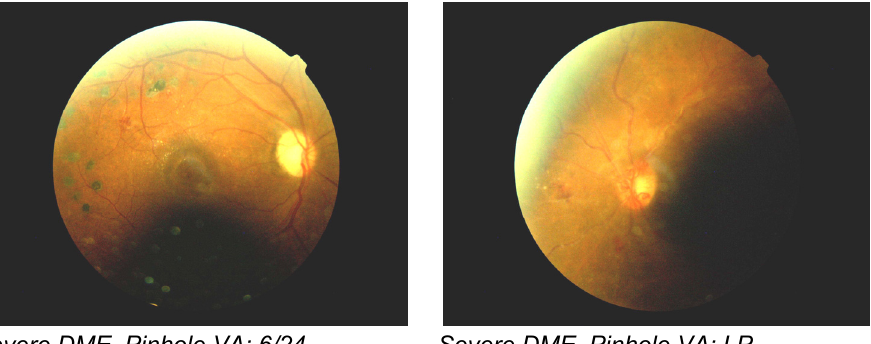
Figure 1 .Non-mydriatic fundus photographs of DME subjects. Severity of DME as diagnosed by two ophthalmologists and corresponding pinhole visual acuities are